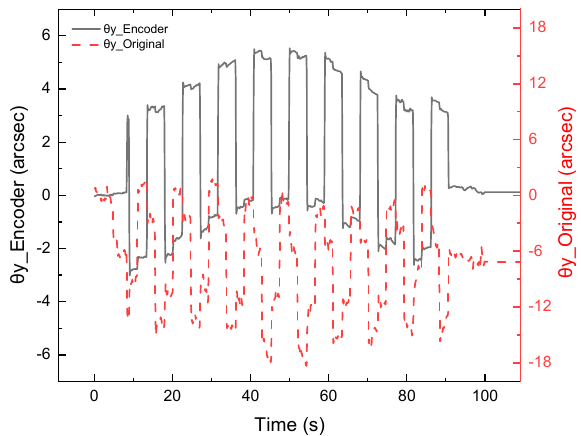
Figure 7. The θ y value (40 ′′ 40 ′′ 100 μ m) comparison between the original value and the value after compensation.